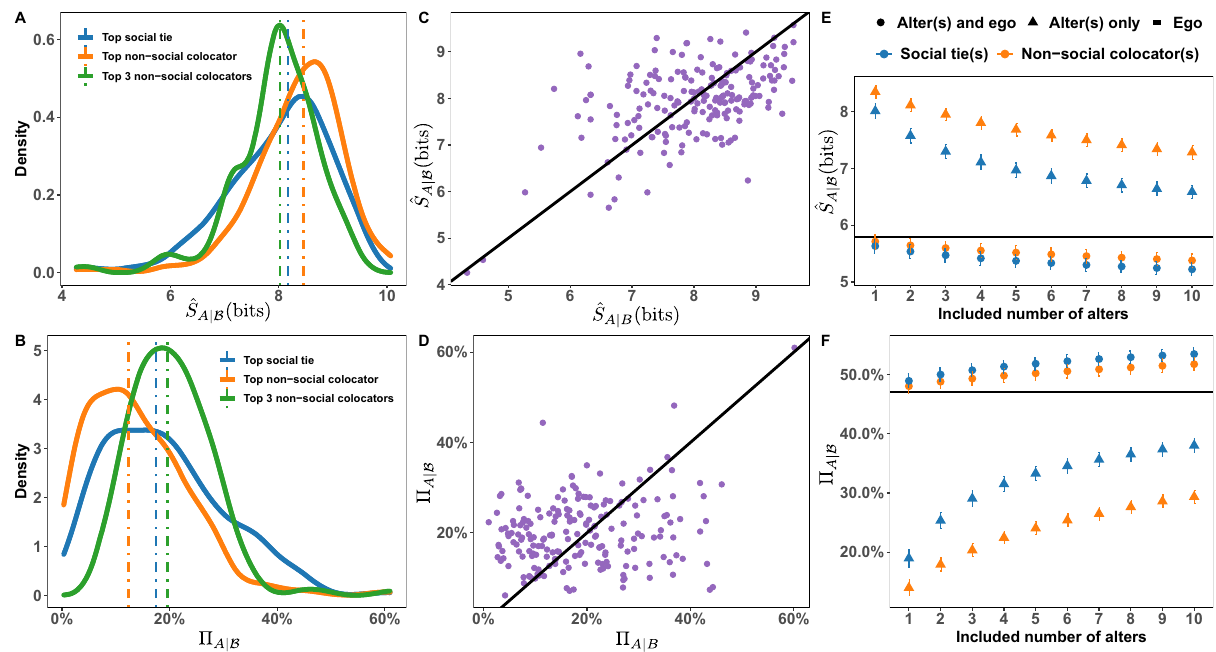
Fig. 2 Cross-entropy and predictability in social ties and non-social colocators. A Distributions of ^ S A j B for the rank-1 social tie (median 8.17 bits), non- social colocator (median 8.46 bits), and ^ S A j B for the top-3 non-social colocators (median 8.02 bits) in Weeplaces. B The corresponding Π A ∣ B for the social (median17.43%), and non-social colocators (median 12.35%), and Π A j B for the top-3 non-social colocators (median 19.60%). C ^ S A j B encoded in the top- social tie as a function of ^ S A j B for the top-3 non-social colocators. Each point corresponds to a single ego and the solid line denotes y = x . D As in panel ( C ) but with predictability instead of cross-entropy. E , F ^ S A j B and Π A j B after accumulating the top-ten social alters and non-social colocators. Horizontal lines denote the average entropy (5.80 bits) of egos and their self-predictability (47.05%). Shapes indicate whether the past trajectory of the ego was included in the sequence (circles) or excluded (triangles). Error bars denote 95%